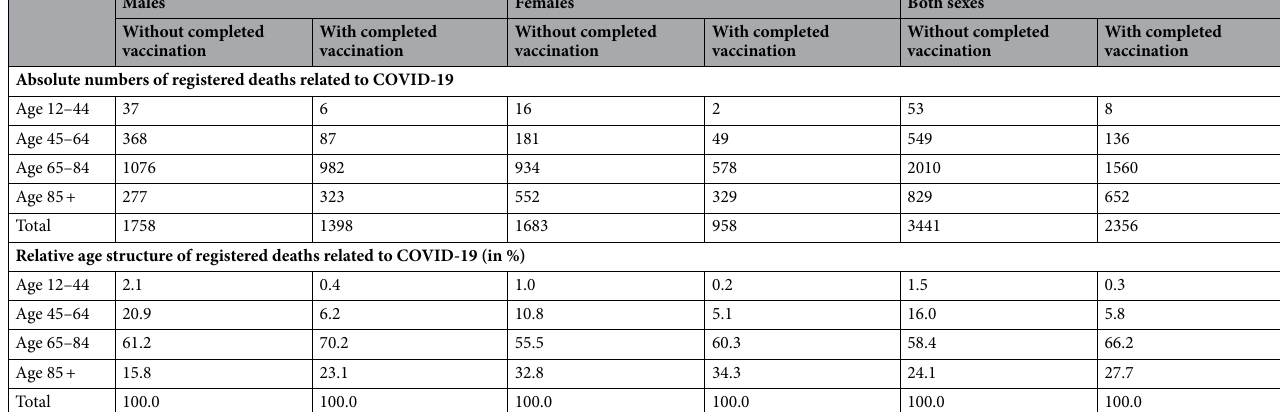
Table 1. Registered numbers of deaths within the population with completed vaccination and without completed vaccination by males, female and, both sexes during the period from October 1 to December 31, 2021. Numbers are absolute numbers, and the relative structure is expressed as (%). Source: author’s calculation 11